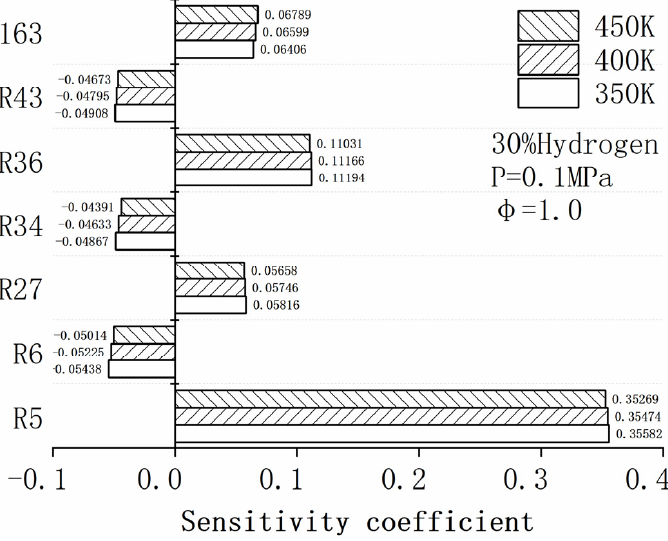
Figure 13. Flow rate sensitivity influenced by temperature (hydrogen composition is 30%, P0 = 0.1 MPa, ϕ = 1).